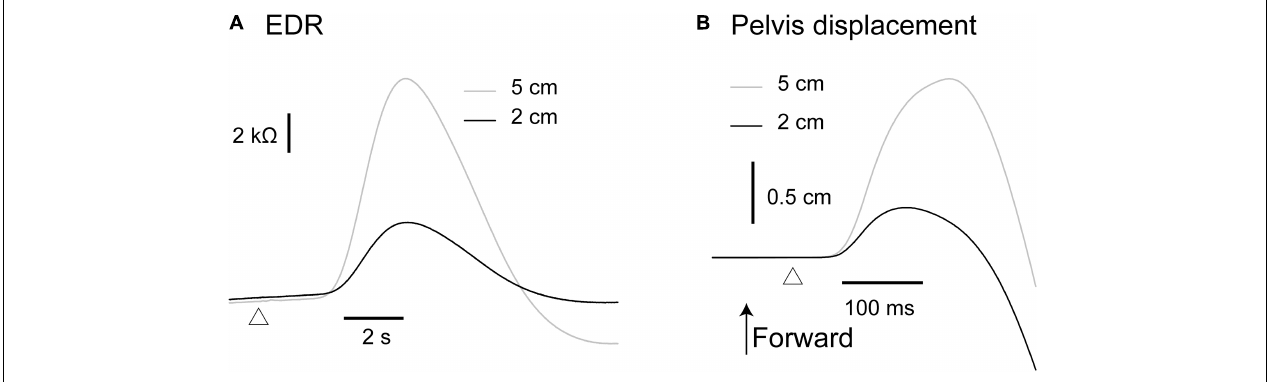
FIGURE 4 | Averaged traces of the EDR (A) and pelvis displacement (B) across 10 trials in the block testing the effect of the translation amplitude in a